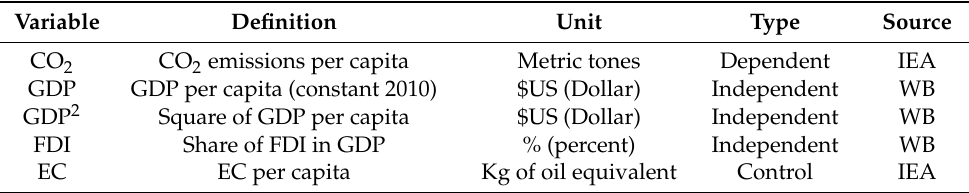
Table 1. Definitions of variables, type, and data